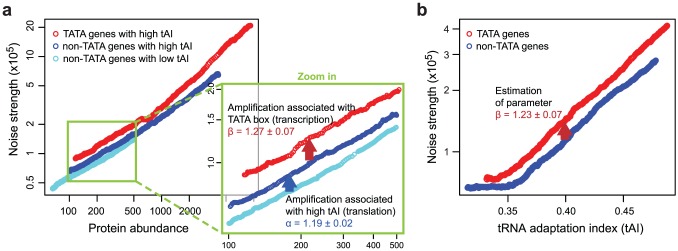
Decomposing noise strength amplification into TATA and tAI associated components.(a) The trend lines for the relation between protein abundance and noise strength (YEPD medium) in three groups of genes: TATA genes with high tAI (red), non-TATA genes with high tAI (blue) and non-TATA genes with low tAI (cyan). High and low tAI mean upper and lower tertile of tAI distribution, respectively. The abundance region where all three trend lines overlap is enlarged. The shift between TATA and non-TATA genes, both with high tAI, represents an amplification associated with the TATA box (transcription feature), β = 1.27±0.07, while the shift between non-TATA genes with high and low tAI represents an amplification associated with high codon usage (translation feature), α = 1.19±0.02. (b) The trend for the noise strength (YEPD medium) as a function of codon usage efficiency (tAI) for TATA genes (red) and non-TATA genes (blue). The shift between these two trend lines provides an alternative estimate of , representing the impact of the TATA box on noise strength.